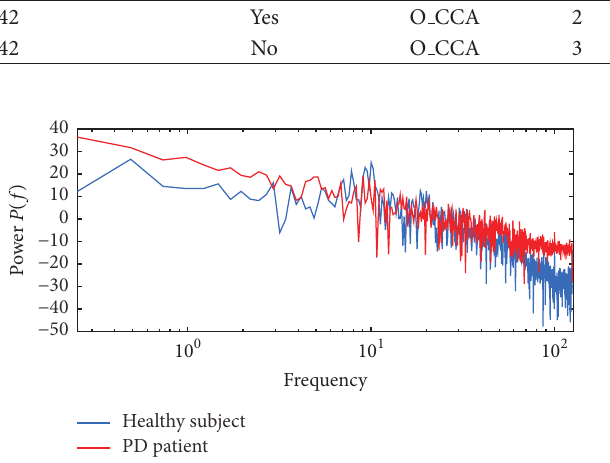
Figure 7: Power spectra (the occipital region O2-channel signal; the blue is healthy subject and red is PD patient).